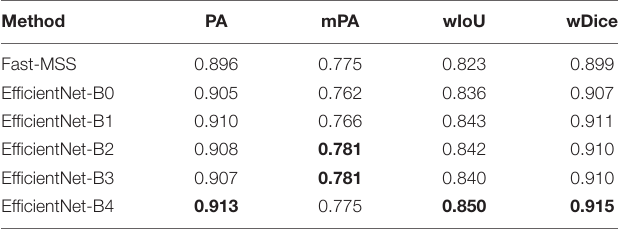
TABLE 4 | Classification scores of 3-D models represented as texture atlases compared against